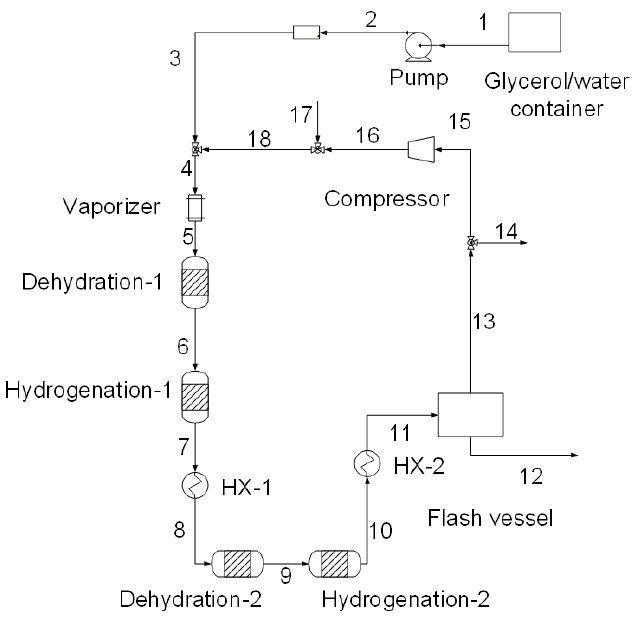
Figure 2. Process flow diagram.